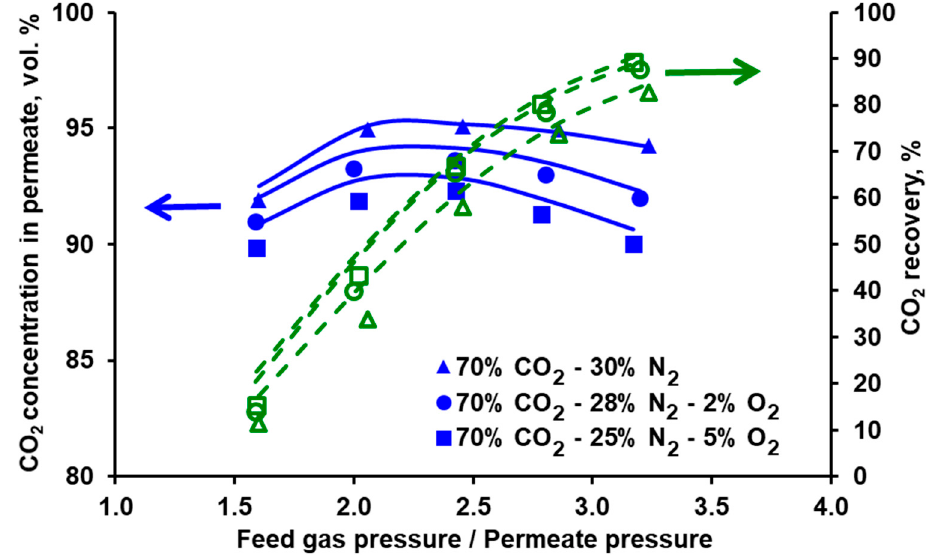
Figure 9. Experimental (points) and theoretical (lines) CO 2 purity and recovery in Air Products PRISM PA1020 module against feed to permeate pressure ratio for various inlet oxygen concentration. Inlet